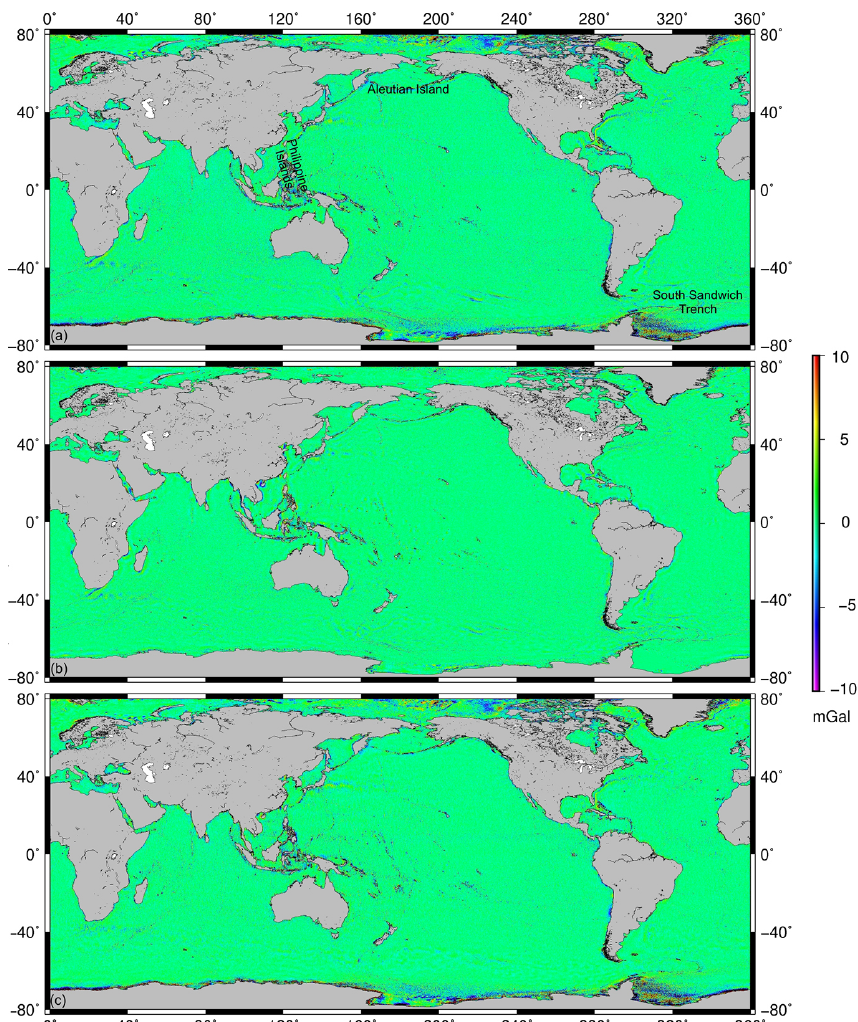
Figure 6. Difference between SDUST2021GRA and recognized marine gravity models: (a) is for SDUST2021GRA and SIO V30.1, (b) is for SDUST2021GRA and DTU17, and (c) is for DTU17 and SIO V30.1.